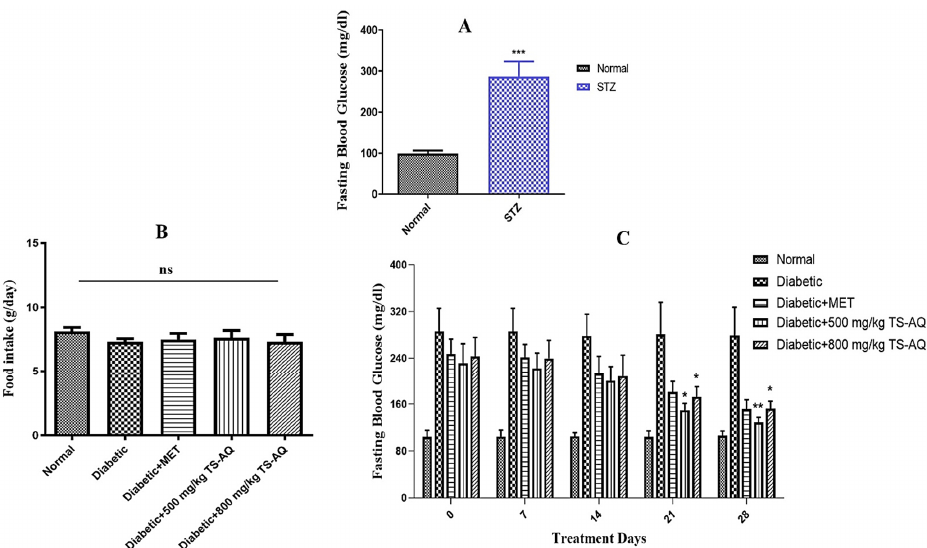
Figure 3. Effect of aqueous extract of thyme on fasting blood glucose levels. ( A ) Blood glucose level of STZ group vs. Normal. The animals injected with streptozotocin (STZ) showed higher levels of blood glucose as compared to normal confirming the induction of diabetes mellitus. ( B ) Average daily food intake. ( C ) Fasting blood glucose (FBG) levels among different groups after every 1 week of the treatment. All the treated groups showed significant reduction in FBG levels after the 3rd and 4th week of the treatment. ns = not significant. * Depict statistical significance. * = p < 0.05. ** = p < 0.01. *** = p < 0.001. ( n = 10 for each group).